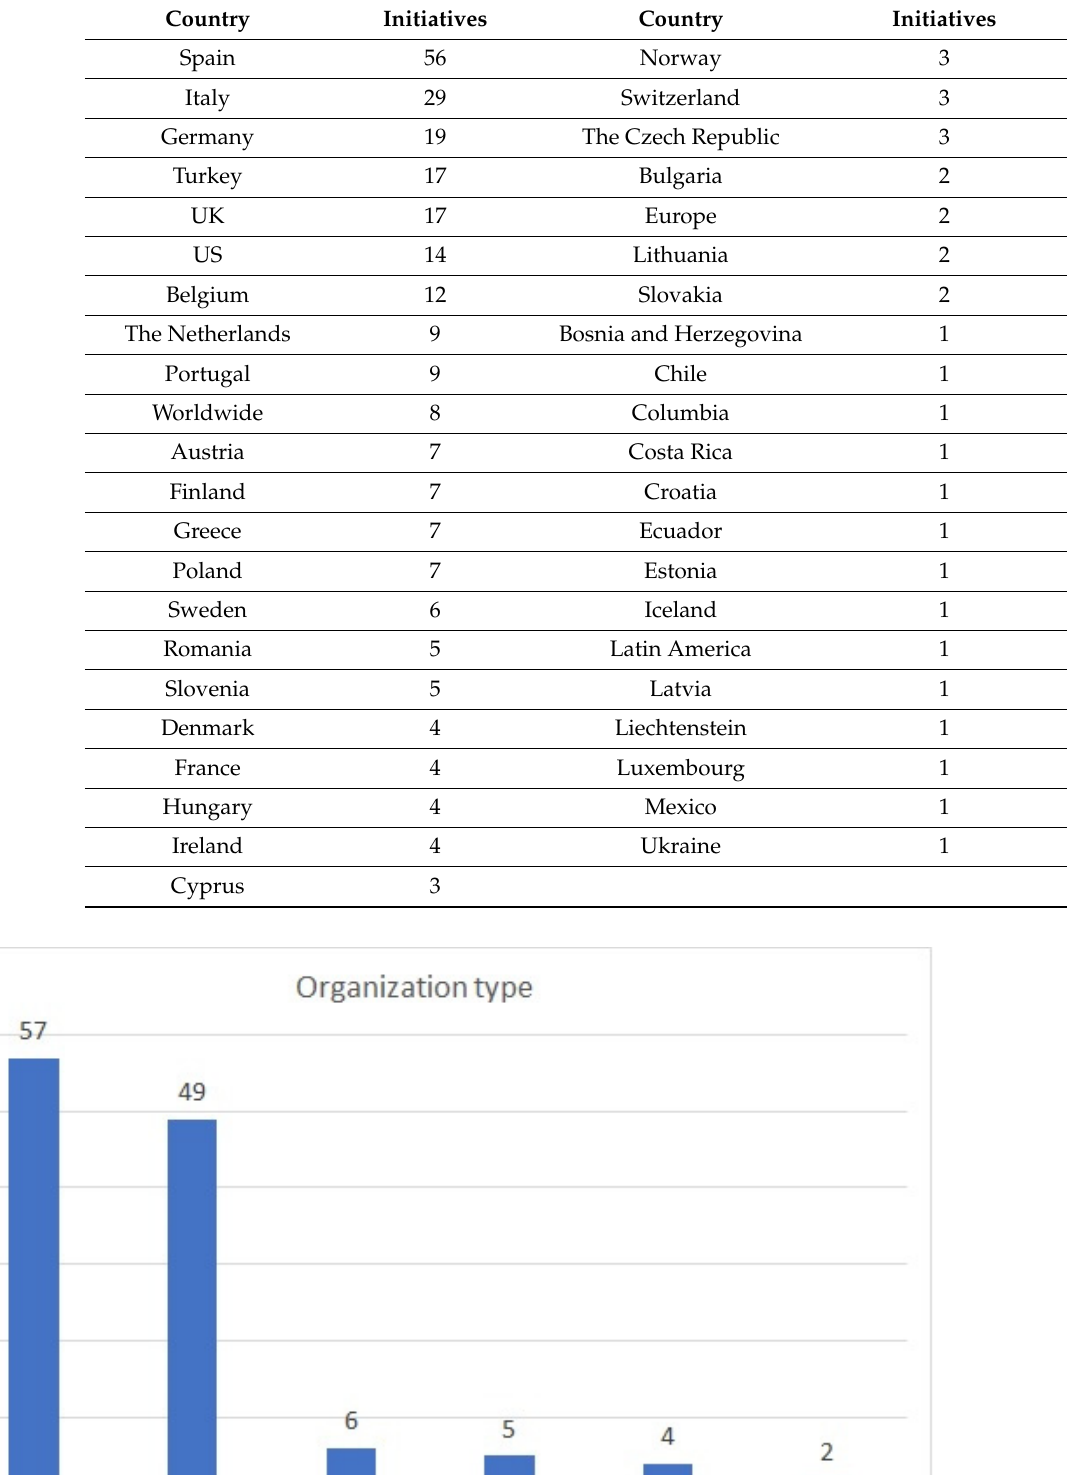
Table 1. Number of initiatives per country. Regions (“Worldwide,” “Europe,” and “Latin America”) correspond to initiatives that define themselves as working at the given level. Initiatives may be active (and thus, listed) in multiple countries.